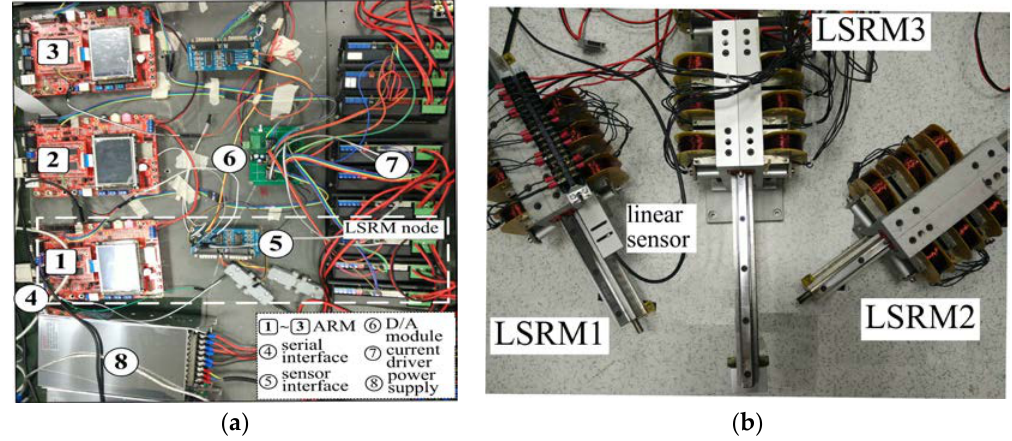
Figure 8. Experimental setup: ( a ) control platforms and drivers; and ( b ) LSRMs.